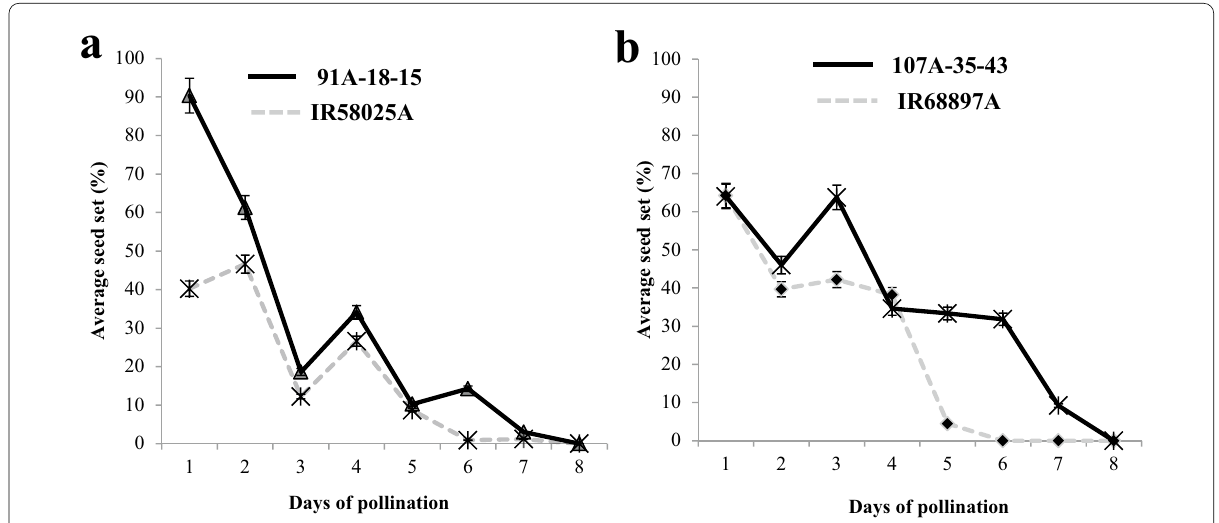
Fig. 6 Graphical representation of stigma receptivity trend of a IR58025A and 91A‑18‑15 and b IR68897A and